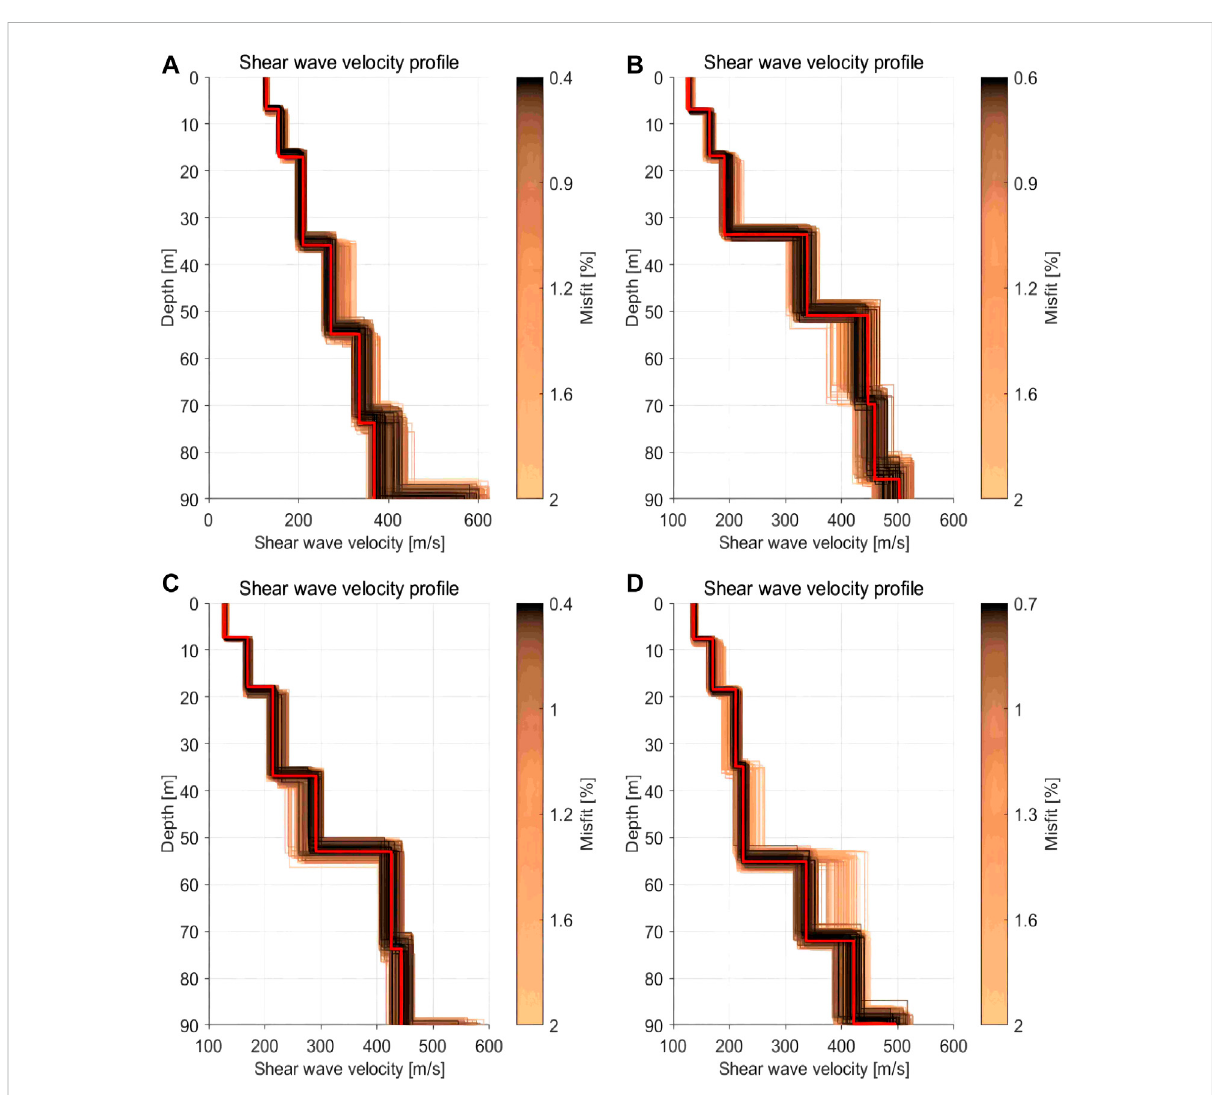
FIGURE 12 The inverted1D shearwave velocities using thefundamental-modedispersioncurvesinFigures 11A – D atChannel 11 (A) andChannel175 (B) in Line I, and at Channel 51 (C) and Channel 200 (D) in Line II, respectively. The red lines denote the best fi tted models that have the lowest mis fi t, and the other lines denote the top 2% best fi tting